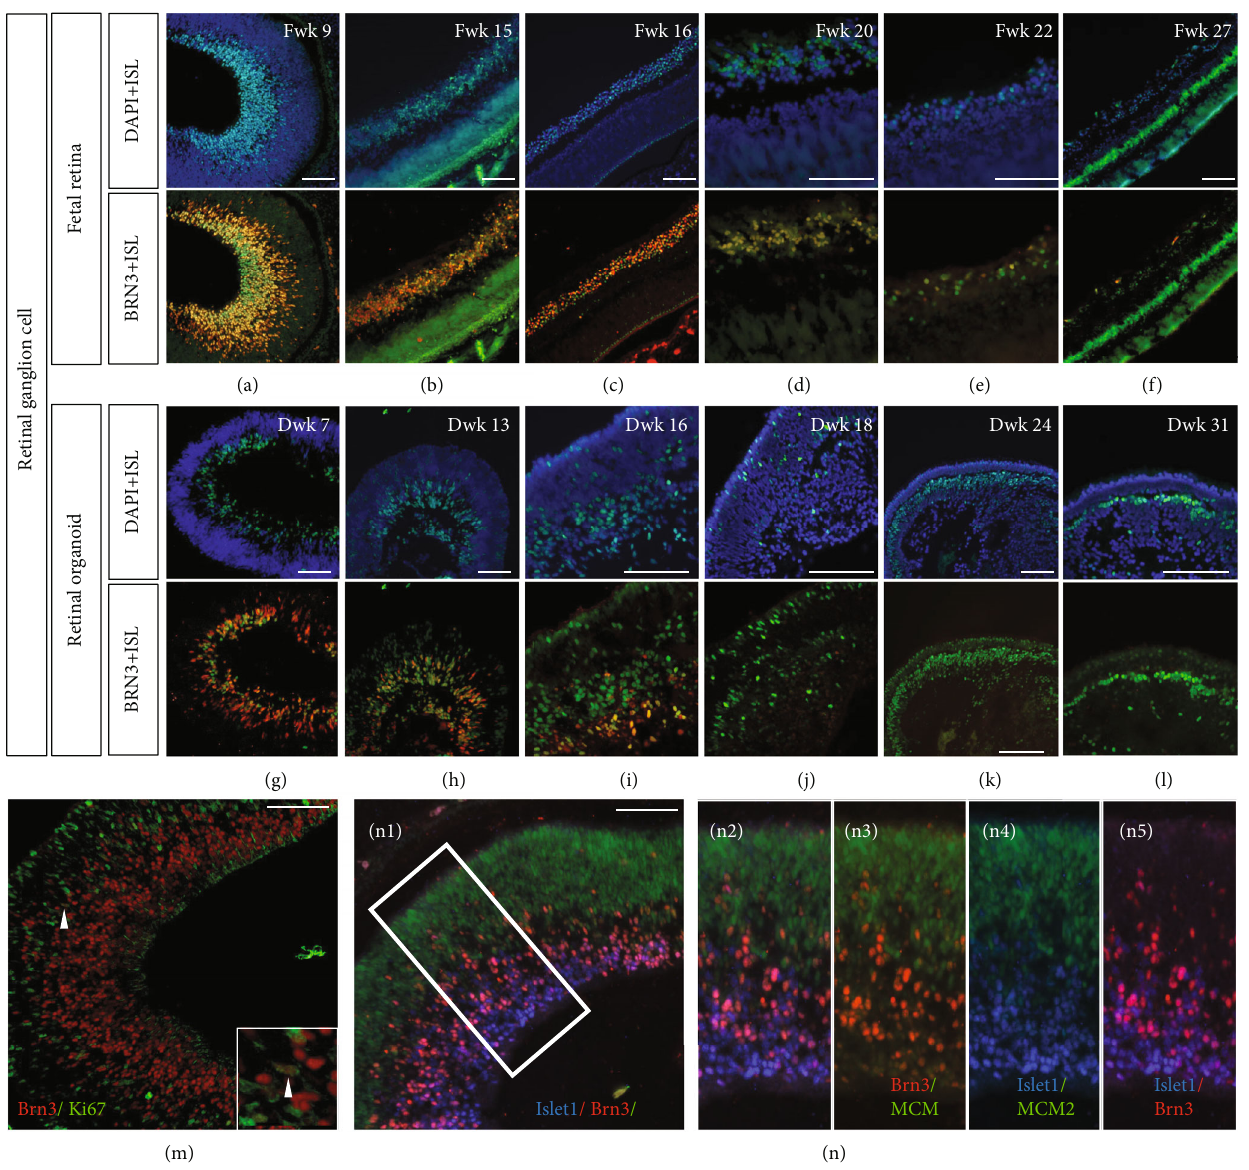
Figure 2: Islet1 coexpressed with Brn3 in retinal ganglion cells. (a – f) Islet1 and Brn3 colabeled retinal ganglion cells in the human fetal retina. From Fwk 20, Brn3 expression gradually decreased and was negative in Fwk 27. (g – i) Islet1-/Brn3-positive retinal ganglion cells were located on the basal side of the retinal organoid but were not laminated well. (j – l) Only sporadic Islet1-positive cells were on the basal side and were Brn3 negative. (m) Most Brn3-positive retinal ganglion cells exited the cell cycle in Fwk 9 retina. The high magni fi cation showed one cell with Brn3 expression but still in the cell cycle. (n1) Triple staining with Islet1, Brn3, and progenitor marker MCM2 in Fwk 9 retina. (n2 – n5) Showing high magni fi cation of the white square in (n1) ( scalebar = 100 μ m